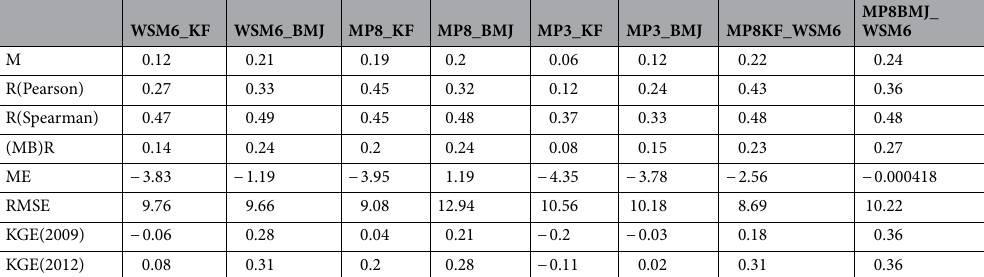
Table 5. Performance metrics for JJAS of the simulations with observation.